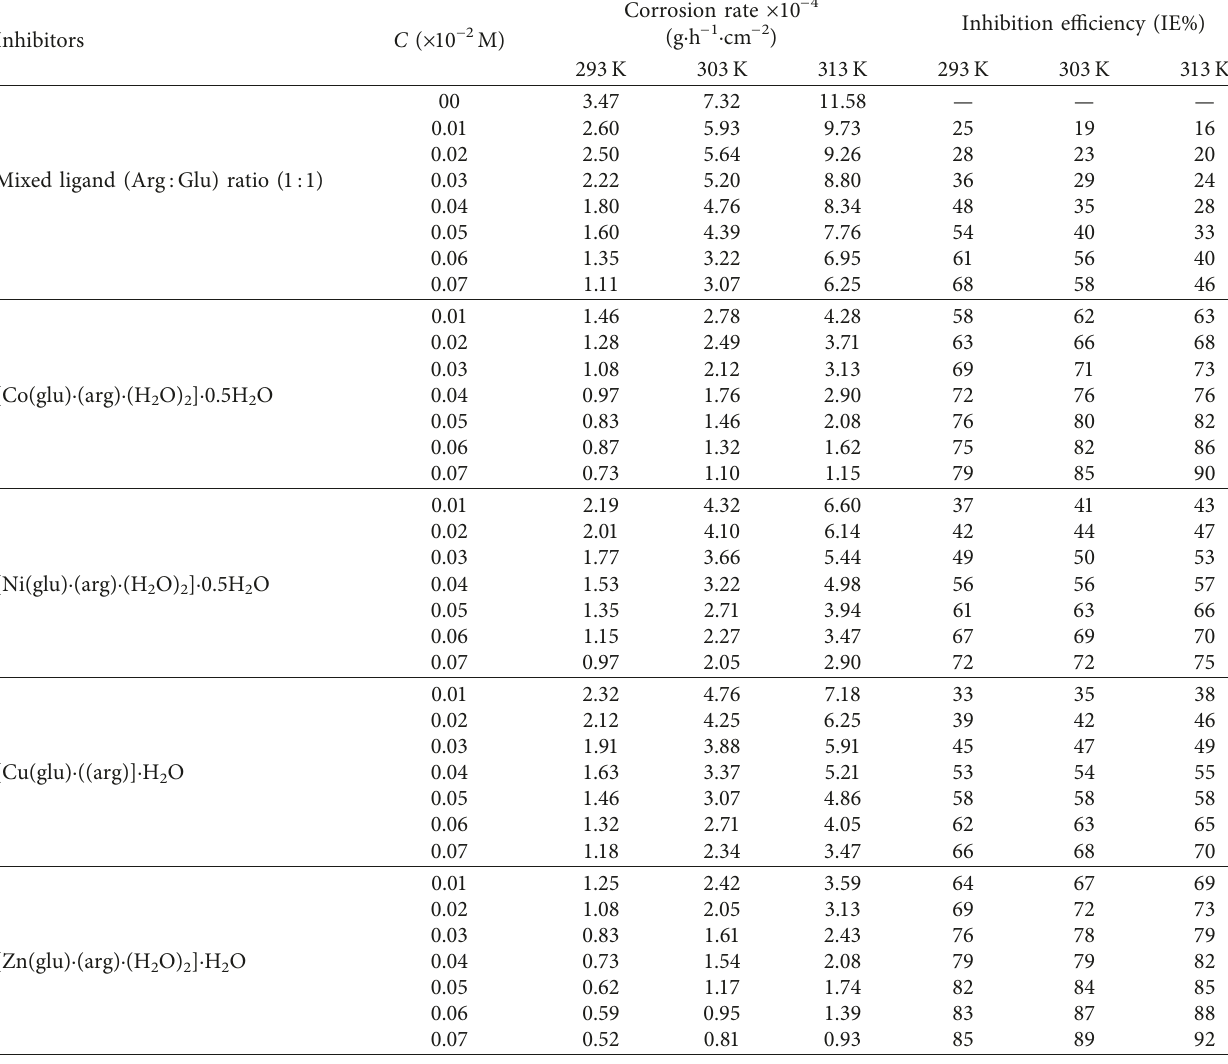
Table 8: Corrosion parameters for aluminum in aqueous solution of 1M HCl in the absence and presence of different concentrations of mixed ligands and their metal complexes at different temperatures for 7hrs. Inhibitors